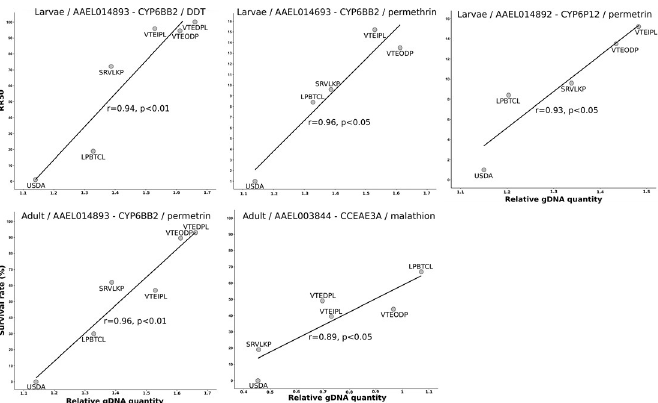
Fig 6. Significant positive correlations identified CNV of detoxification genes and population resistance levels. Resistance levels are expressed as RR 50 for larvae and % survival to WHO insecticide test for